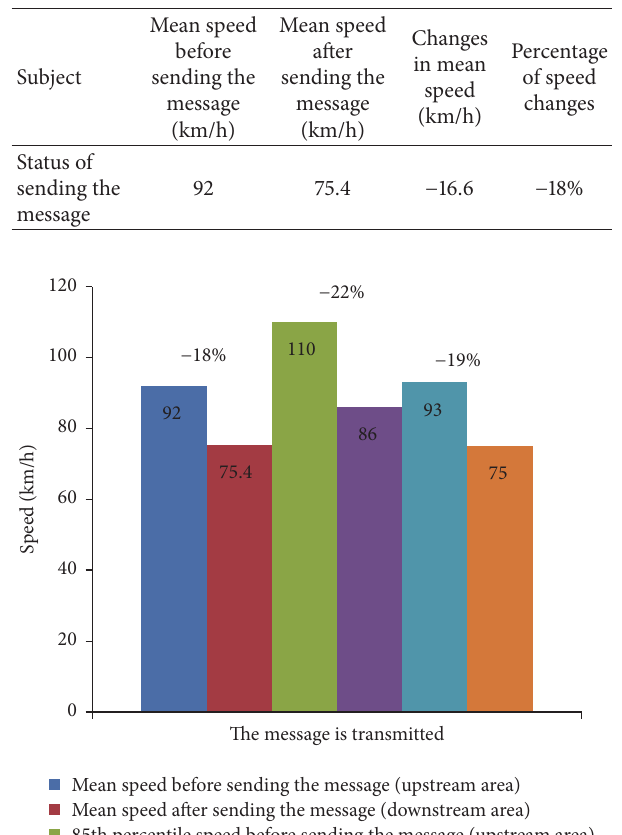
Figure 10: The effect of the Voice Sign System on mean, 50th percentile, and 85th percentile speed of